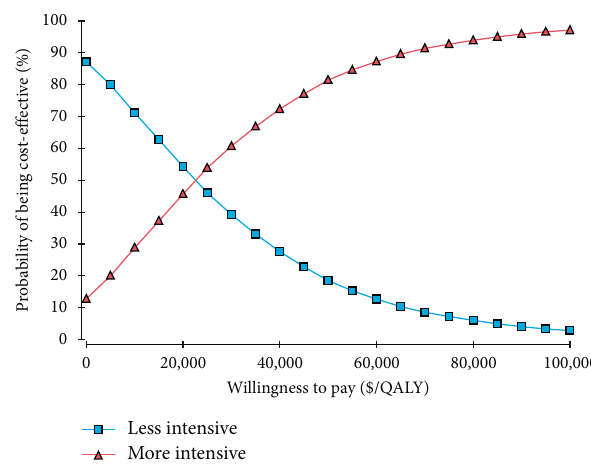
Figure 3: Cost-effectiveness acceptability